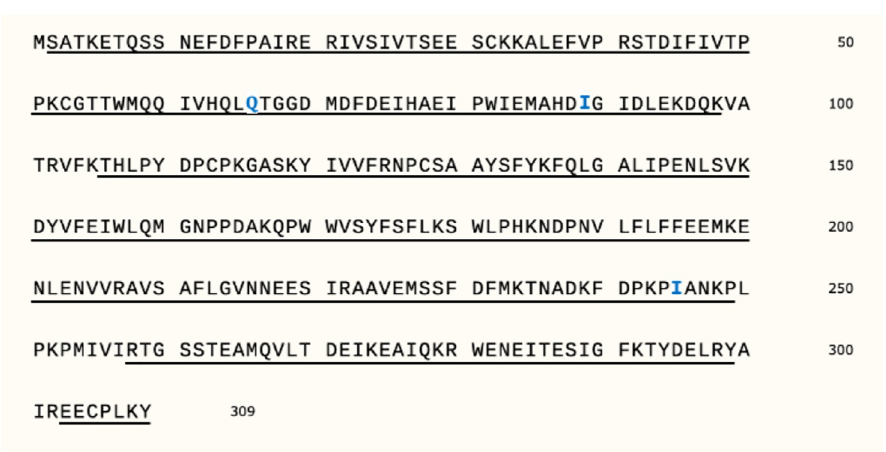
Fig 6. The Renilla coelenterazine sulfotransferase (Coel-ST) amino acid sequence from ORF 12.16 and LC-MS/MS peptide coverage. The sequence segments covered by observed peptides are underlined. Three amino acid residues (Q66, I89, and I245) that do not match the sequence of ORF 12.16 are indicated in blue. (Note that residues 66, 89 and 245 do match one of the other isoforms, see Table 2).